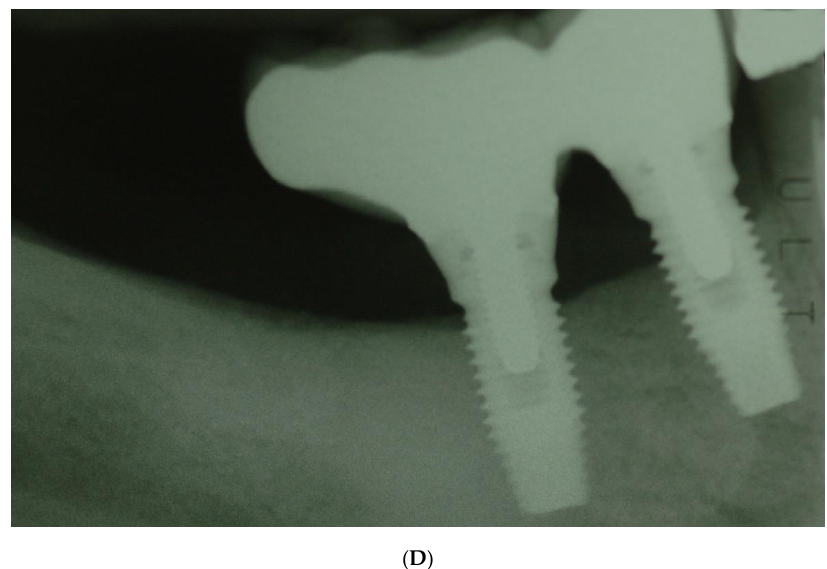
Figure 4. ( A ) Same area after packing with a collagen sponge and insertion of an implant at #46. ( B ) Clinical image after insertion of a healing screw in the implant at #46 and initial closure with 4/0 interrupted silk sutures. ( C ) Postoperative intraoral radiograph of area #45–#47. ( D ) Radiograph one year after the definitive prosthetic restoration.